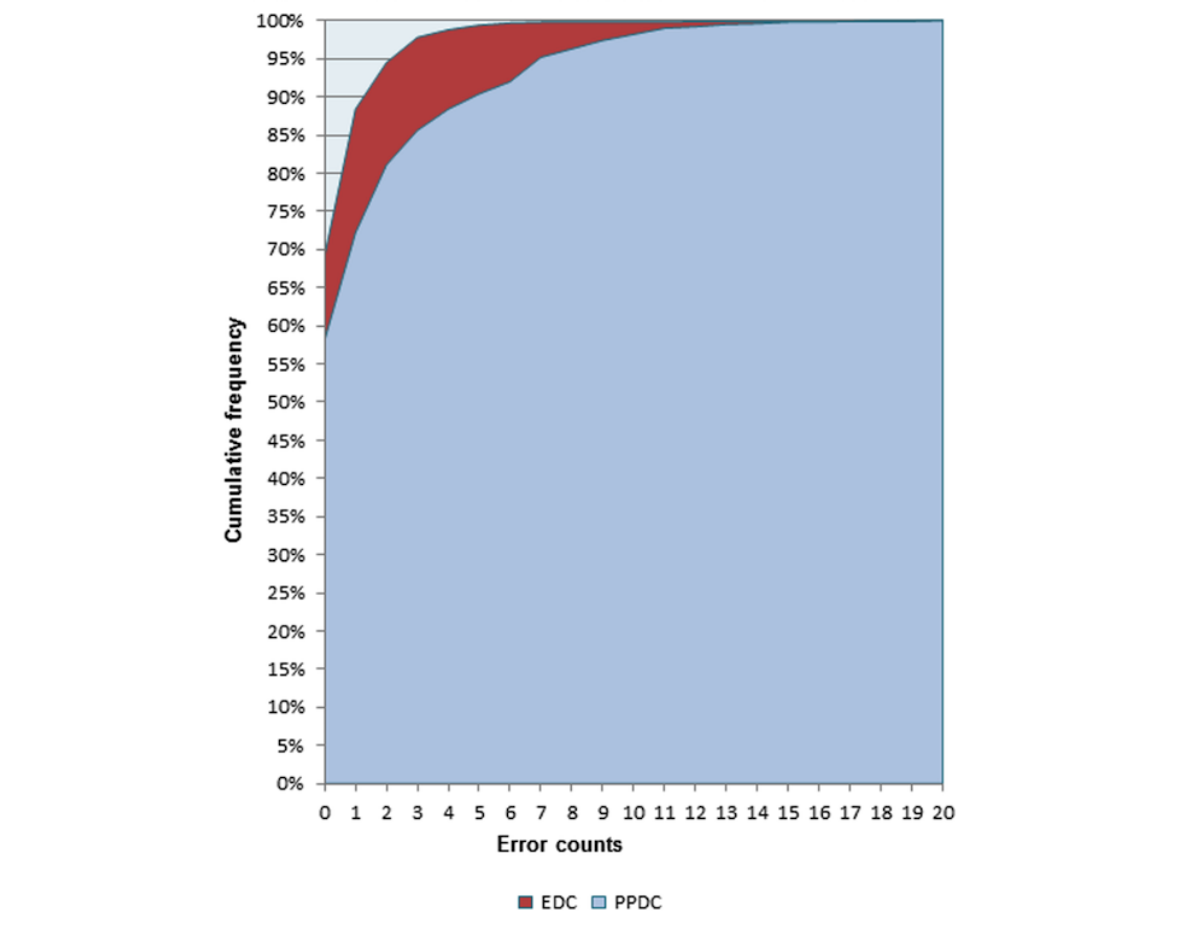
Figure 2. Frequency of error comparison among the electronic data capture (EDC) tools using tablet computer and paper and pen data capture (PPDC) tools during a survey in the demographic survey site in 2016, Dabat, northwest